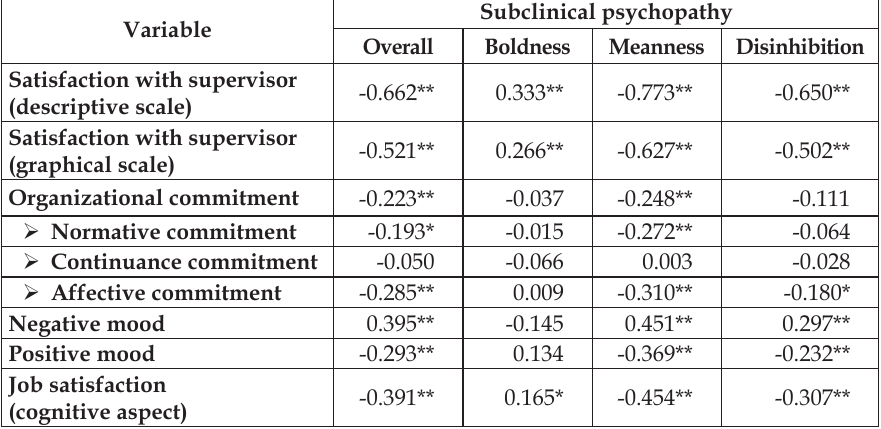
Table 3. Correlations in the